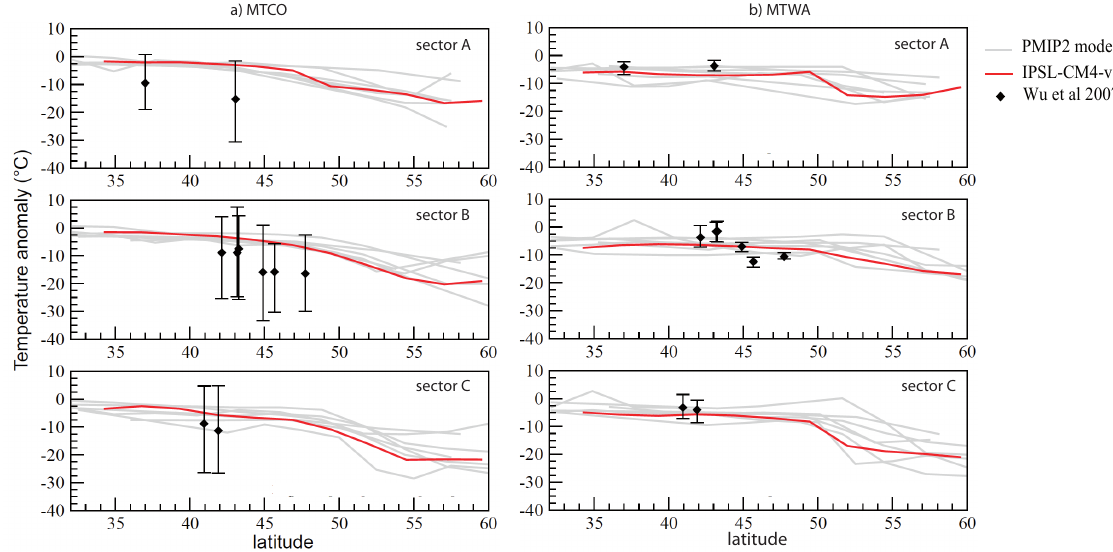
Fig. 5. Difference in (a) the mean temperature of the coldest month (MTCO) and (b) mean temperature of the warmest month (MTWA) between the LGM and present-day simulated by IPSL CM4 (red) and other GCMs from the PMIP2 project (grey), for 3 longitude bands over Western Europe, between 32 ◦ and 60 ◦ N. The limits of the three sectors are plotted in Fig. 8. Sector A: lon= − 15/-2 ◦ , Sector B: lon= − 2/10 ◦ , Sector C: lon=10/20 ◦ . Black diamonds are MTWA and MTCO values reconstructed by Wu et al. (2007) with the associated uncertainty range.